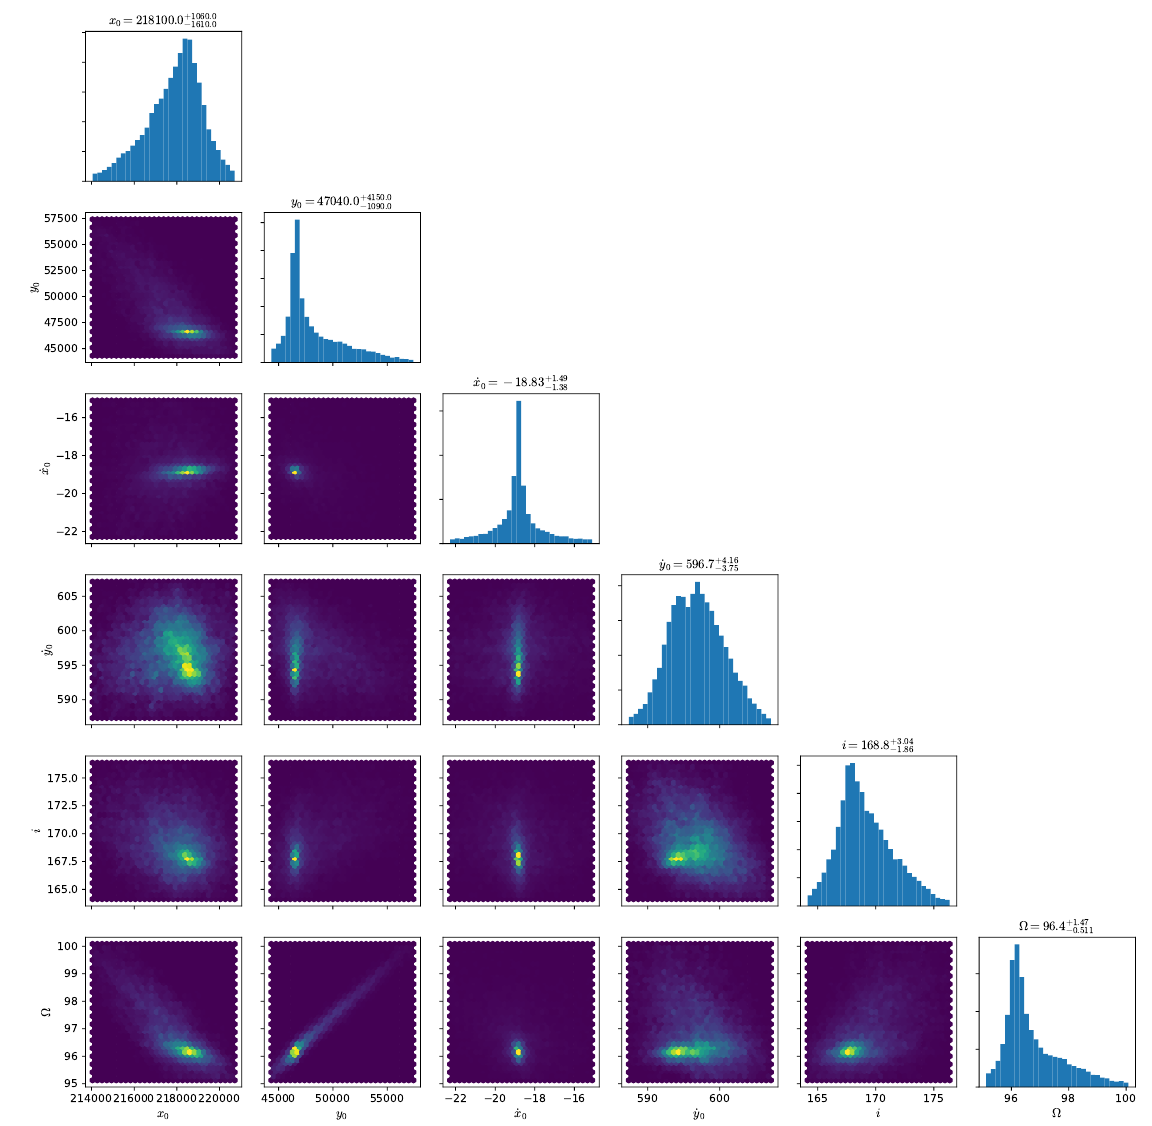
Figure A2. The posterior distribution of the orbital parameters of the S38 star. The units are the same as in Figure